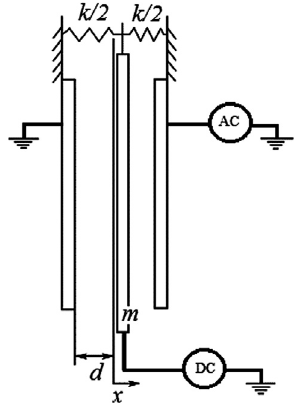
Fig. 1. Micro-mechanical